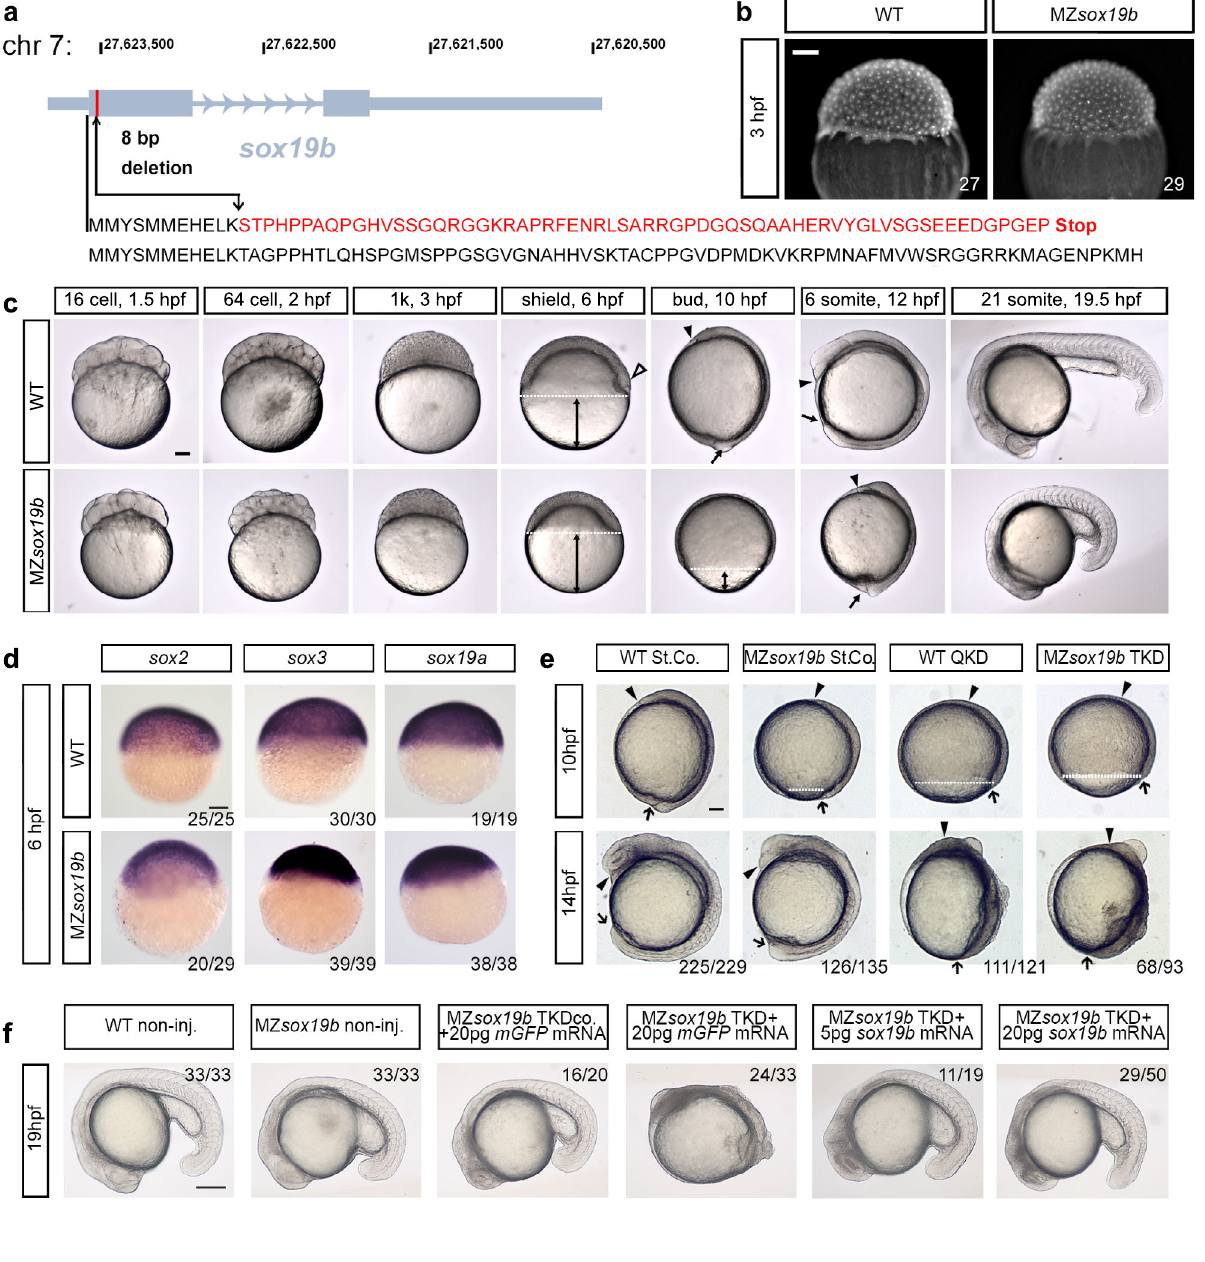
Fig. 1 Redundant activity of SoxB1 family factors Sox19b, Sox19a, Sox2 and Sox3 is required at post-gastrulation developmental stages. a Disruption of the sox19b gene on chromosome 7 by introducing an 8 bp deletion. b No difference in cell division rates between WT and MZ sox19b was observed prior to MBT (see also Fig. S1). c MZ sox19b embryos are delayed in gastrulation (see Fig. S2 for statistics). Simultaneously collected WT and MZ sox19b embryos were let to develop at 28,5 °C, pictures of representative embryos were taken at the indicated time points/developmental stages of the wild type. In zebra fi sh embryos, embryonic shield forms at 6 hpf at the dorsal side during gastrulation (hollow arrowhead in the wild type). MZ sox19b embryos are still phenotypically at 40% epiboly (blastula). Gastrulation ends with tail bud formation at 10 hpf. MZ sox19b embryos are still at 80 – 90% epiboly gastrula stage. d In situ hybridization for sox2, sox3, and sox19a , in WT and MZ sox19b embryos, lateral views. e Quadruple Sox19a/b, Sox2, and Sox3 knockdown embryos complete gastrulation, but show later defects in tail bud formation and axis elongation. 1-cell stage wild-type or MZ sox19b embryos were injected with control morpholino (StCo), or QKD (quadruple knockdown) mix (Sox2, Sox3, Sox19a, and Sox19b morpholinos), or TKD (triple knockdown, Sox2, Sox3, Sox19a morpholinos), as indicated. f Axis elongation defects in MZ sox19b -TKD are rescued by injection of sox19b mRNA. 1-cell stage MZ sox19b embryos were injected with either TKD mix or TKDco mix (Sox2, Sox3, Sox19b morpholinos), together with Sox19b or control GFP mRNA, as indicated (see Fig. S3d – g for additional statistics). Double black arrows show the distance from epiboly border (white dotted line) to the vegetal pole. Black arrow — tail bud, black arrowhead — head process. Scale bar 200 µ m. Scale bars in b – e : 100 µ m, in f : 200 µ m.